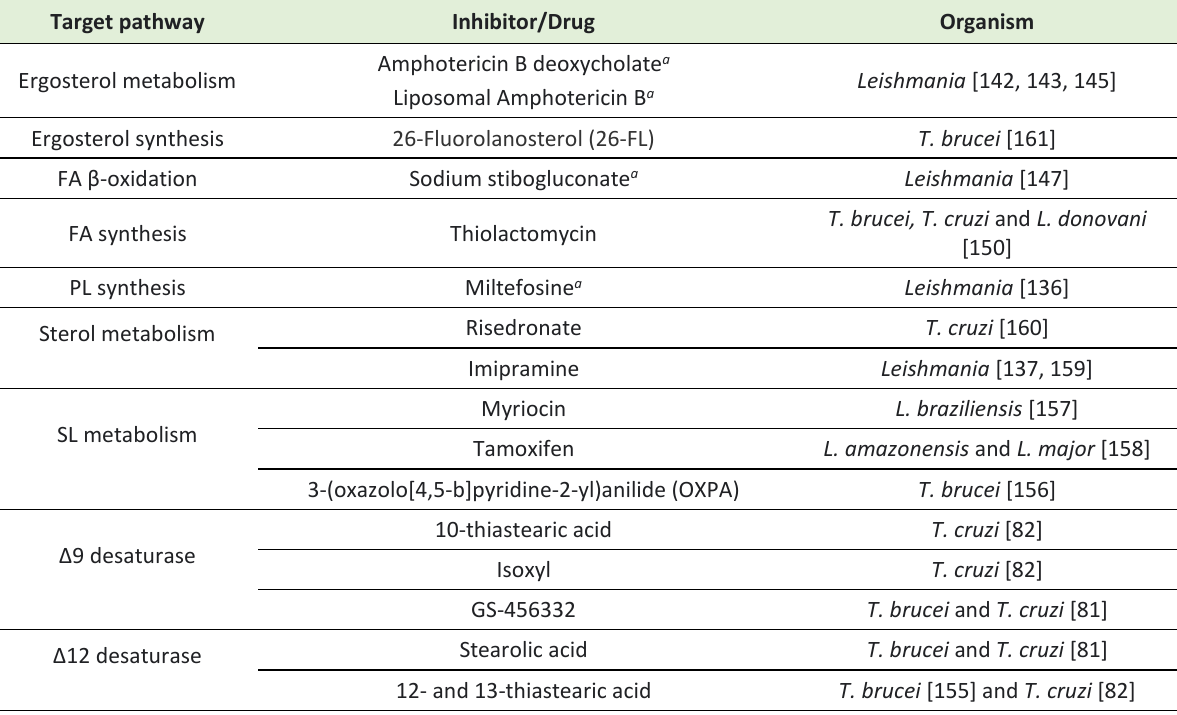
TABLE 1. Registered drugs and potential inhibitor s targeting trypanosomatids’ FA and lipid -related pathways. Target